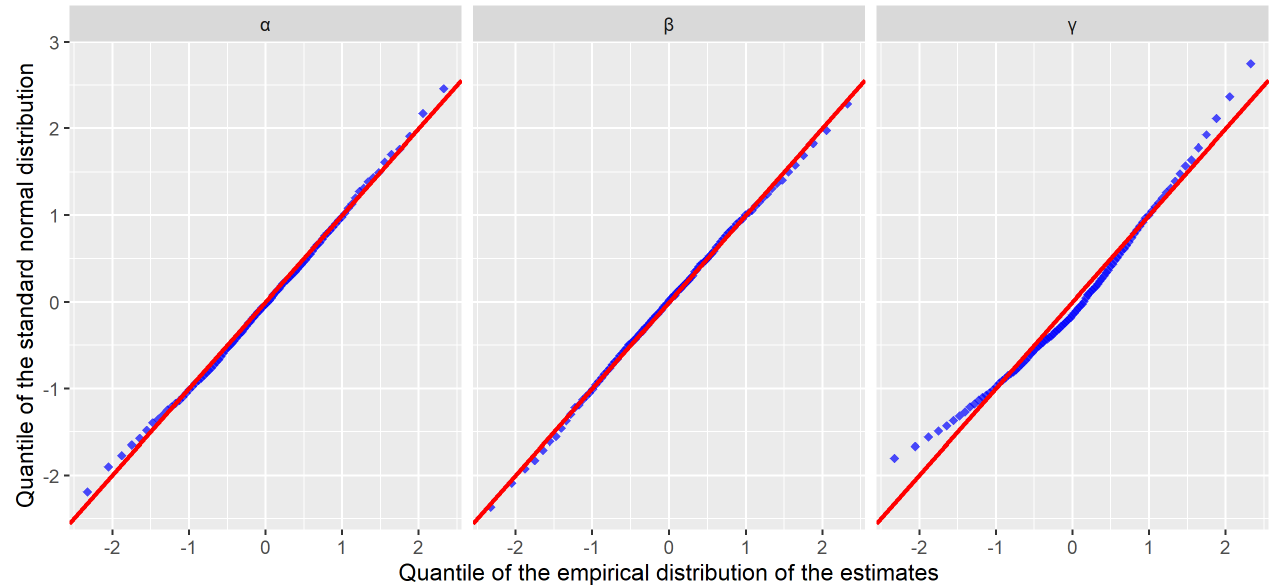
Figure 2. Quantile-quantile plot. The quantiles of the the empirical distributions are calculated with the normalized estimation results.